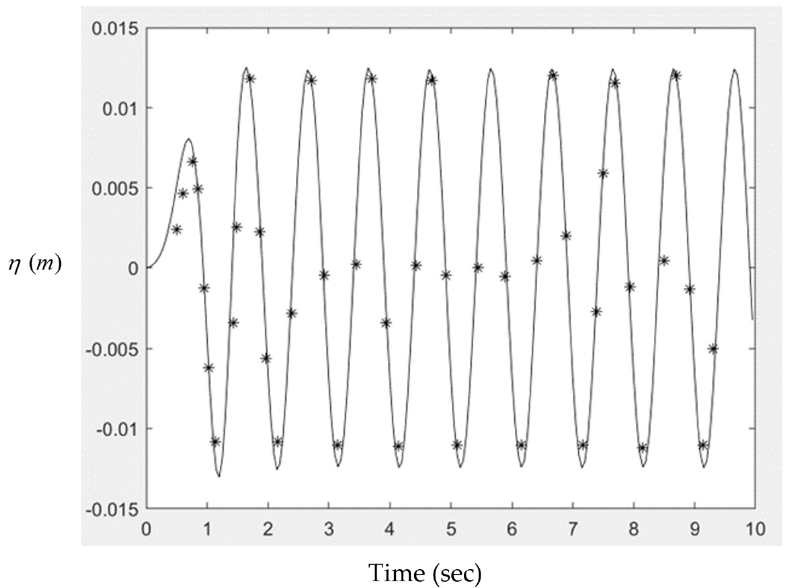
Figure 7. Comparison of free surface elevation between present solution (line) and experimental results (discrete star) [29].